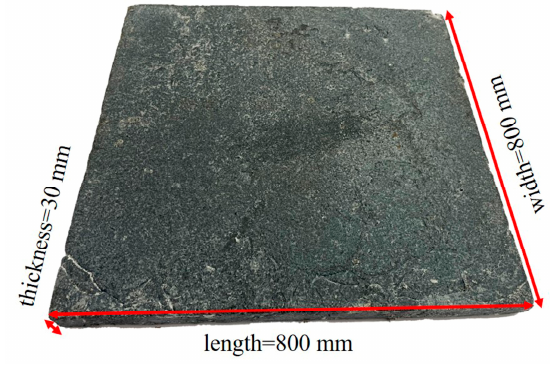
Figure 2. The prefabricated SSPCM plate.